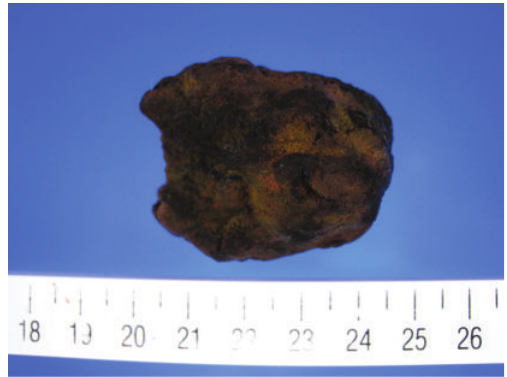
Figure 4: A bezoar impacted in the distal